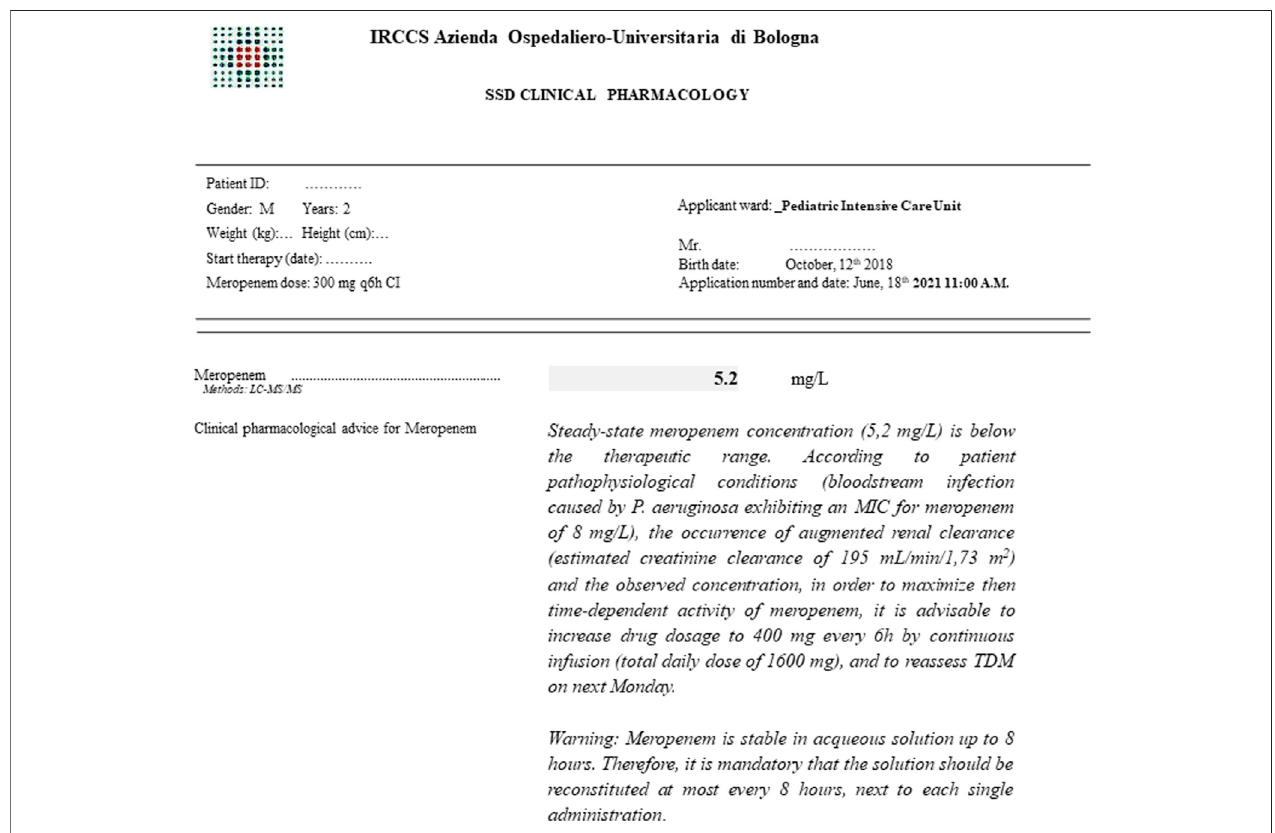
FIGURE 1 | Example of a TDM-guided clinical pharmacological advice for personalizing antibiotic treatment with meropenem in a critically ill paediatric patient affected byaugmented renal clearance (estimated creatinine clearance according tobedsiderevised Schwartz equation)and concomitant bloodstream infection due to Pseudomonas aeruginosa exhibiting a minimum inhibitory concentration for meropenem of 8 mg/L. SSD: departmental